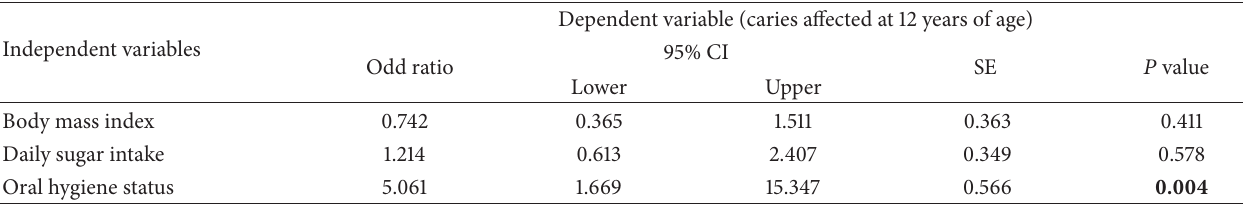
Table 3: Multiple linear regression analysis of oral hygiene status, body mass index, and daily sugar intake on caries prevalence in 12-year-old school